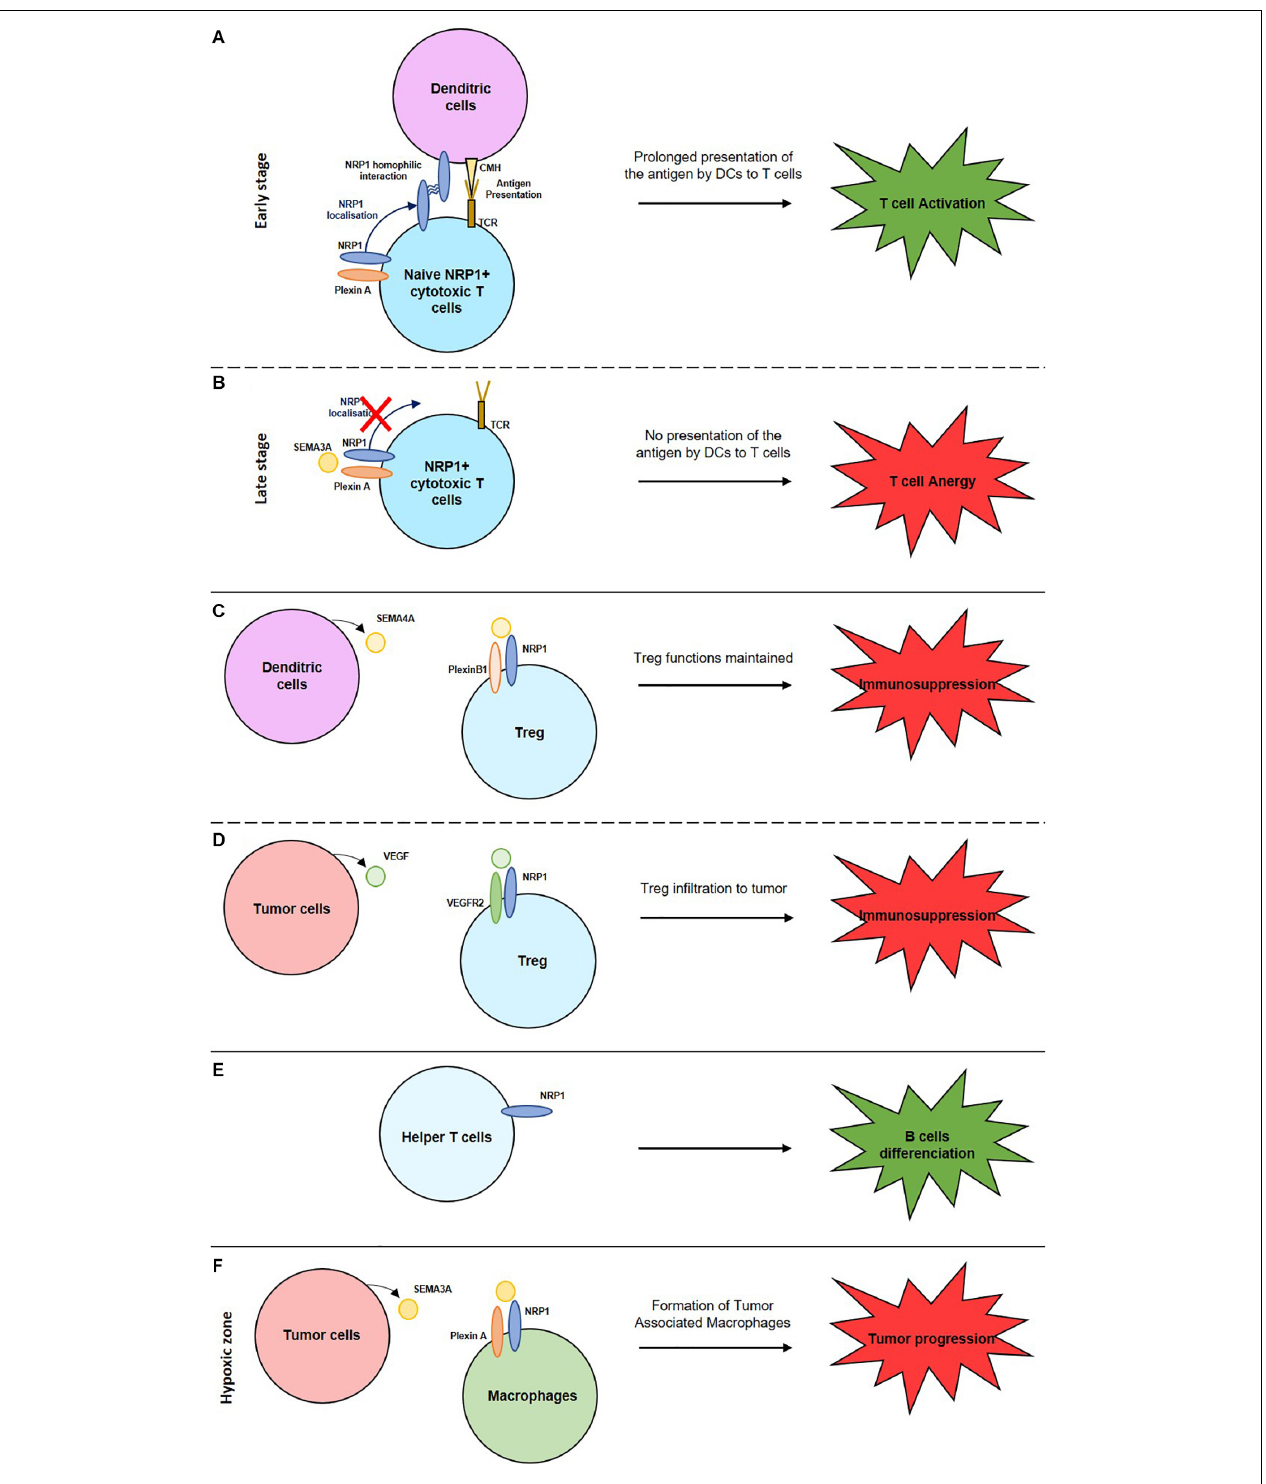
FIGURE 1 | Role of NRPs in the activation or suppression of the immune system. (A) NRP1 homophilic interaction enhances the interaction between naive cytotoxic T cells and dendritic cells inducing a prolonged antigen presentation and so T cell activation. (B) Expression of SEMA3A by mature cytotoxic T cells inhibits NRP1 localisation and induces T cell anergy. (C) Interaction between NRP1, expressed by Treg cells, with SEMA4A, expressed by dendritic cells maintain Treg functions. (D) Interaction between NRP1, expressed by Treg cells, with VEGF, expressed by tumor cells, enable Treg cells infiltration into the tumor and induce an immunosuppression. (E) NRP1+ helper T cells induce B cells differentiation to activate their immune response. (F) Interaction between NRP1, expressed by macrophages, with SEMA3A, expressed by tumor cells, induce the formation of tumor associated macrophages (TAM) and so a tumor progression.